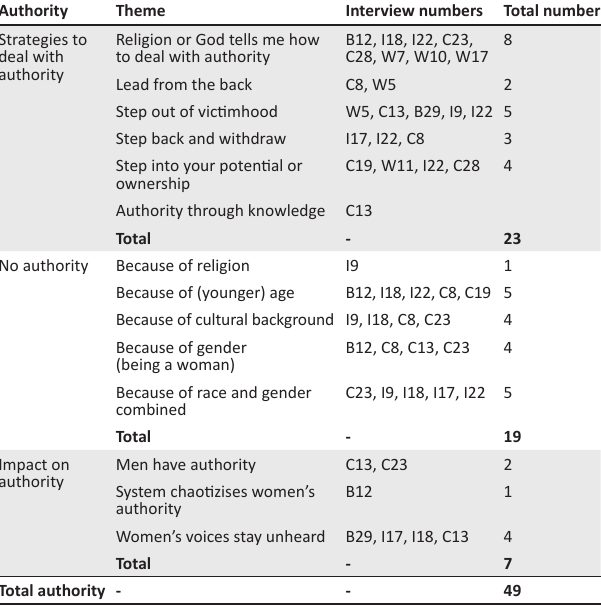
TABLE 7: (De-)authorisation of women leaders.